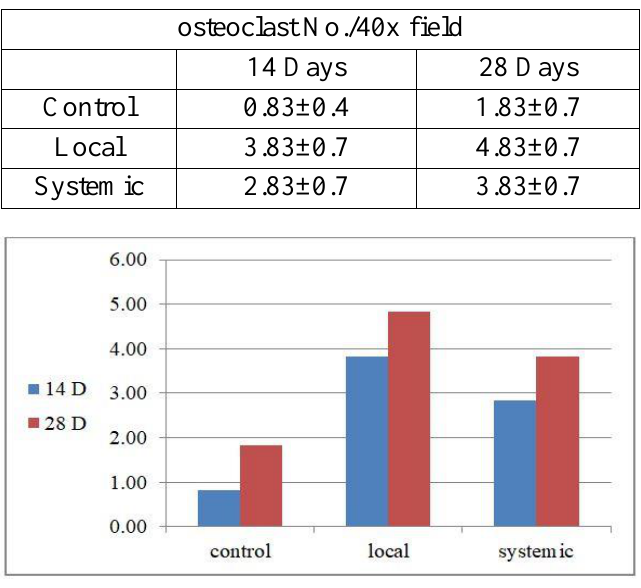
Table 2: Statistical analysis of the number of osteocytes: Osteocyte No./40x field Methods of